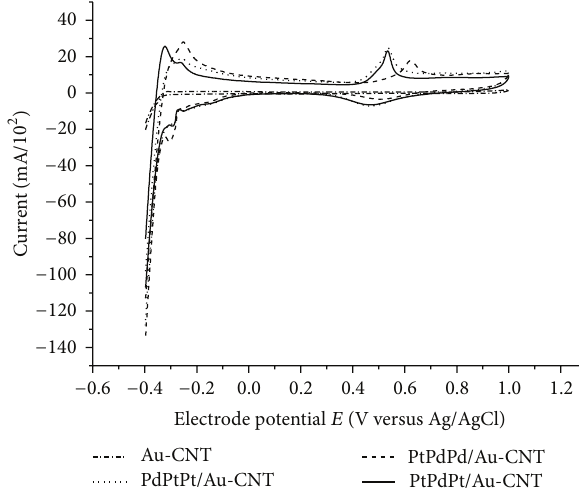
Figure 1: Cyclic voltammograms recorded in 1MH 2 SO 4 solution at Au-CNT, PdPtPt/Au-CNT, PtPdPd/Au-CNT, and PtPdPt/Au-CNT in the potential range − 0.40 to 1.00 V at a scan rate 0.05 V ⋅ s −1